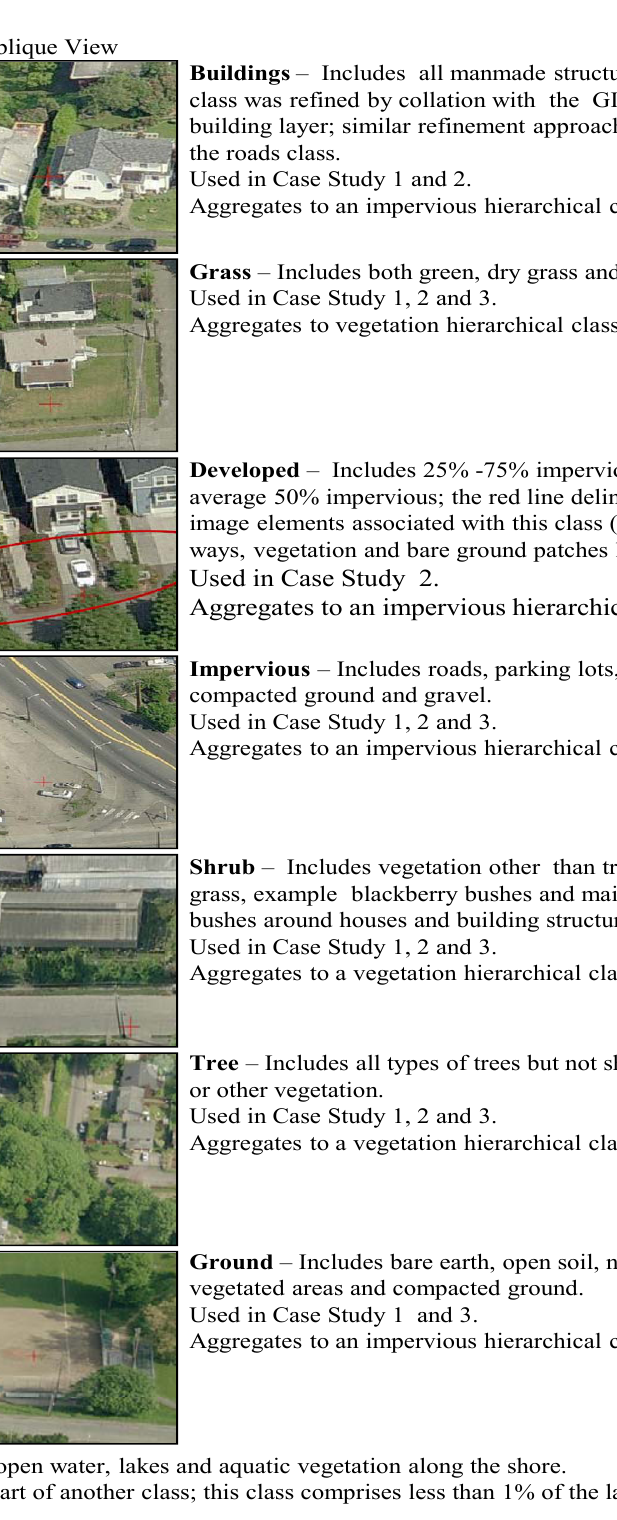
Figure 2. Example of image segments representative of the described LULC classes. Cyan polygons show an example of the LULC class being delineated in the OBIA segmentation, adjacent segments are shown in white and can represent a different class. The oblique image is centered on the delineated segment. The 2002 aerial and co-registered 2009 oblique images are not shown at the same scale; north is